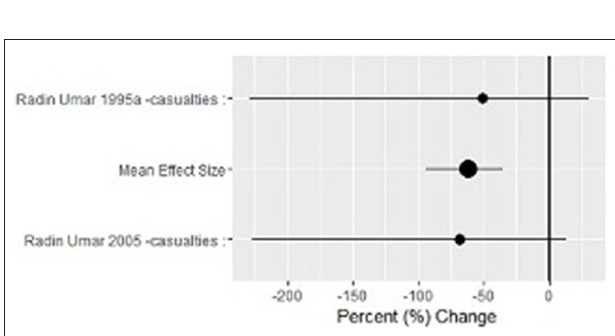
FIGURE 10 | Primary outcome: percent change in the number of ‘road accident casualty’ after daytime running-headlight